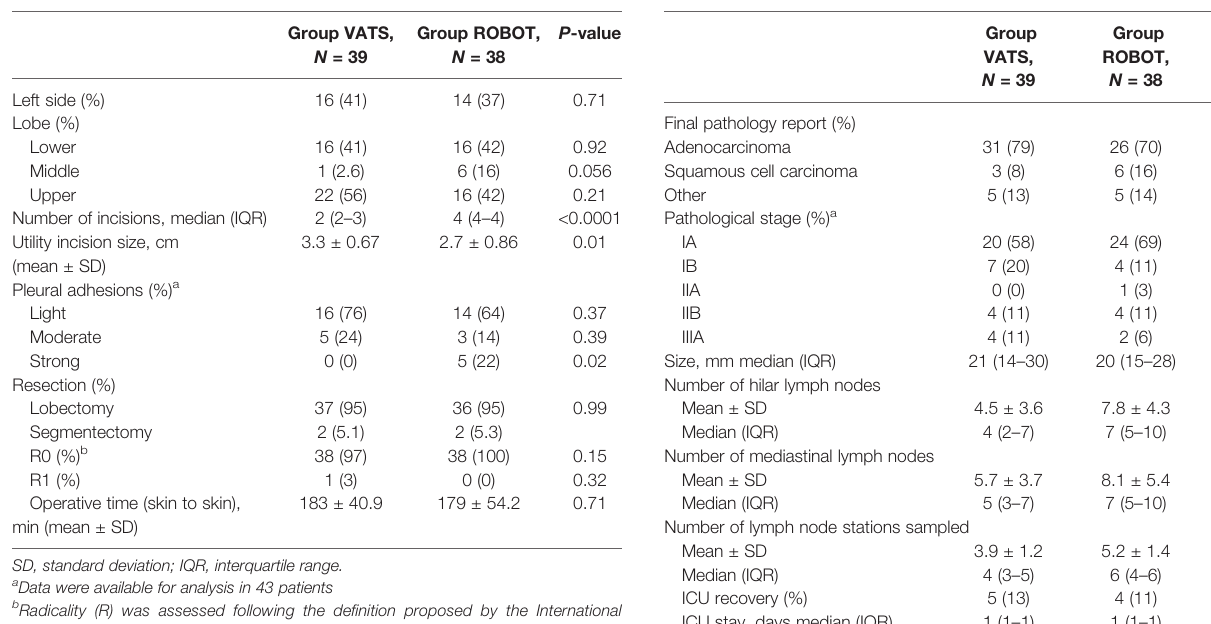
TABLE 2 | Intraoperative characteristics in the VATS and ROBOT groups of patients.